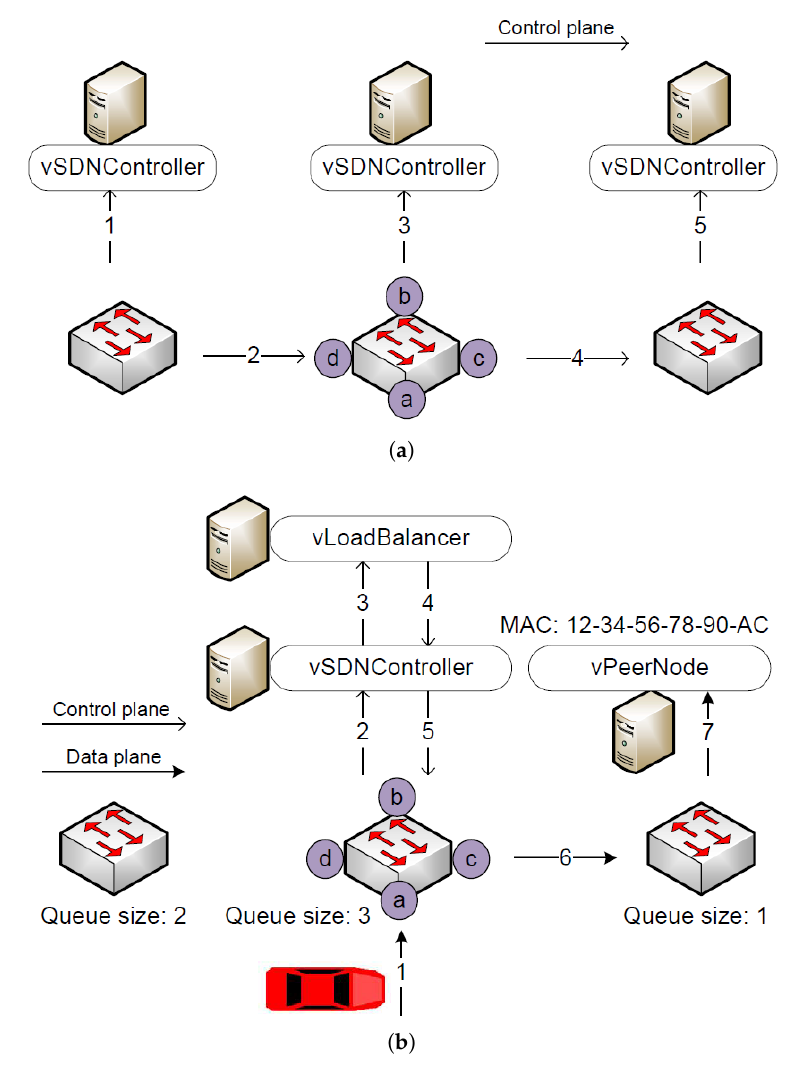
Figure 4. Communication protocol. ( a ) How to update the extended MAC Table. ( b ) How to distribute the